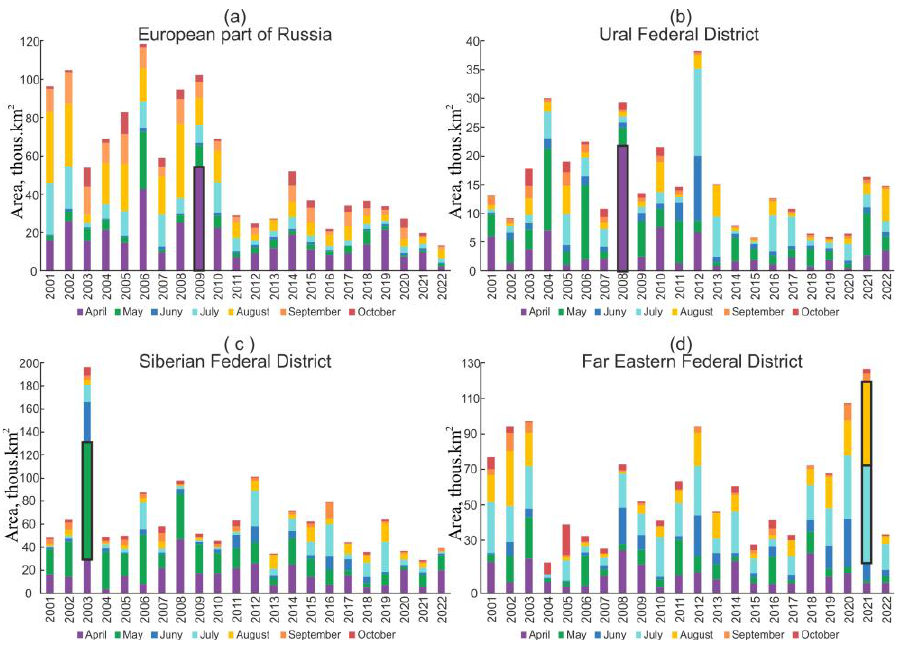
Figure 3. Monthly distribution of wildfire areas with highlighted maximum values during fire seasons (April – October) in 2001 – 2022 in the European part of Russia ( a ), as well as in three large Federal Districts: Ural ( b ), Siberian ( c ), and Far Eastern ( d ) during fire seasons (April – October) in 2001 – 2022.